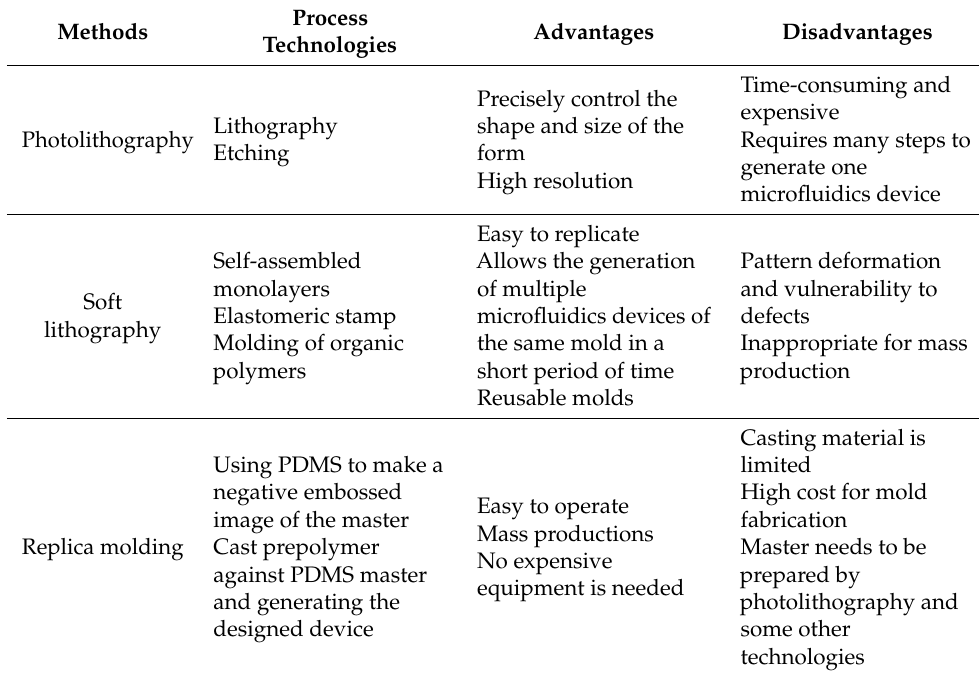
Table 2. The microfabrication methods for